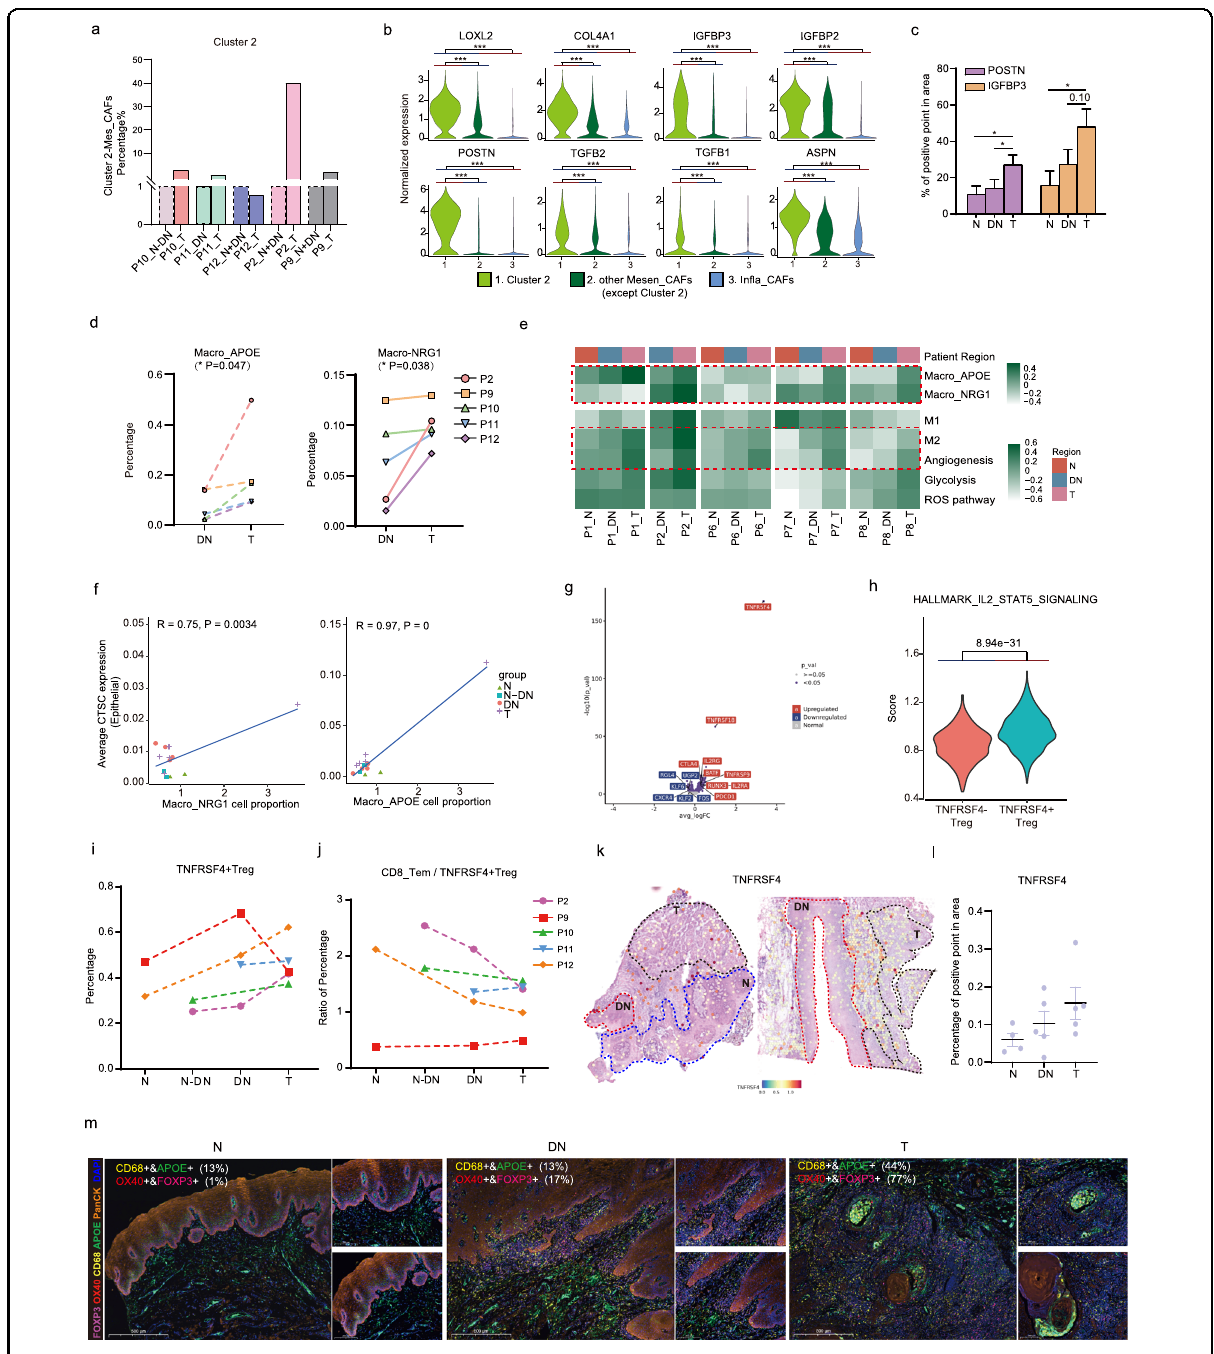
Fig. 5 (See legend on next